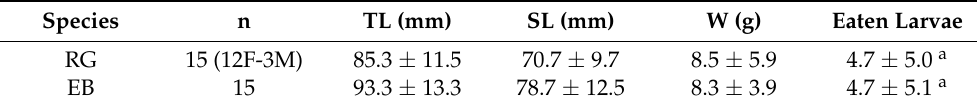
Table 1. Biometric data of the round goby (RG) Neogobius melanostomus and European bullhead (EB) Cottus gobio . Total length (TL), standard length (SL), weight (W), and the average number of Sarcophaga carinaria larva consumed during the 28 h experiment. Data are mean ± SD. Same letter in the superscripts within the rows indicate no significant differences between species in measured